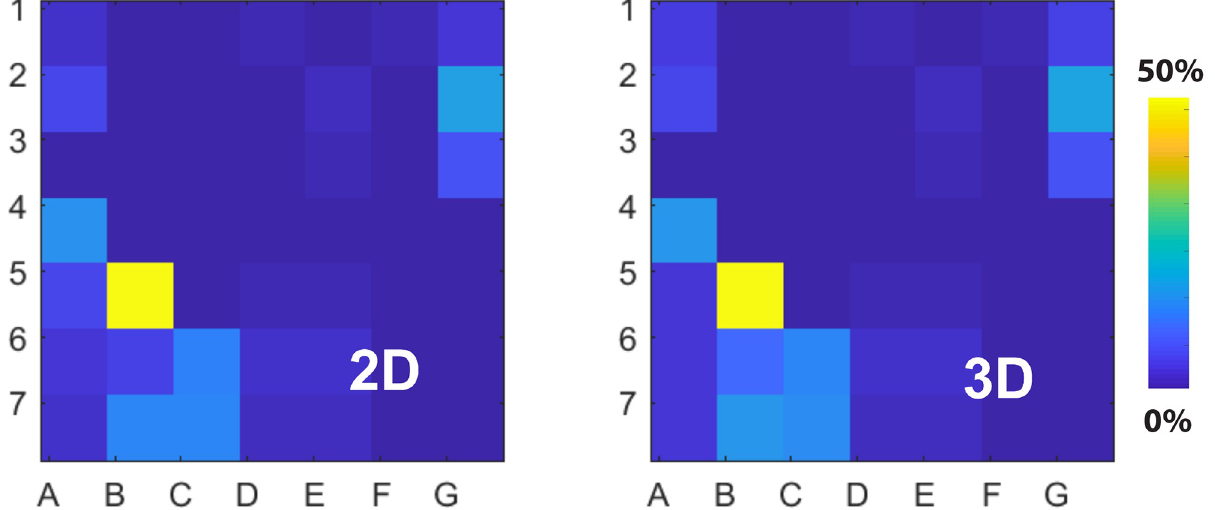
Fig 4. Tip density maps are conserved between 2D and 3D. The tip or phase singularity density map computed using 2D phase maps (left) and 3D maps, projected onto 2D (right) for the patient of Fig 2A–2C. Both maps are virtually identical with a correlation coefficient of r = 0.994. Percent values represent the proportion of frames during which a given electrode grid contained a